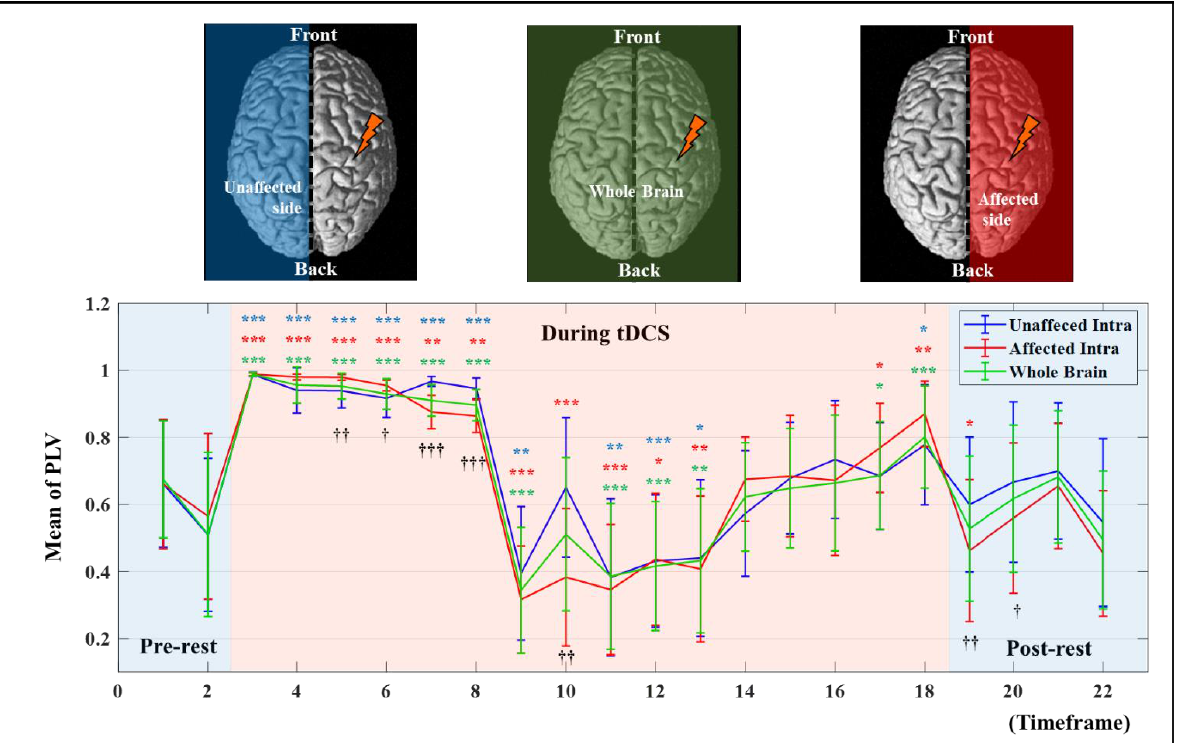
Figure 4. The mean PLV values based on the timeframe in each hemisphere and a whole brain. The error bar indicates the standard deviations between all related channels. The asterisk indicates a statistical difference compared to the pre-test value (* p < 5/100; ** p < 1/100; *** p < 1/1000), and the cross indicates a statistical difference between affected and unaffected intrahemispheric connections († p < 5/100; †† p < 1/100; ††† p <